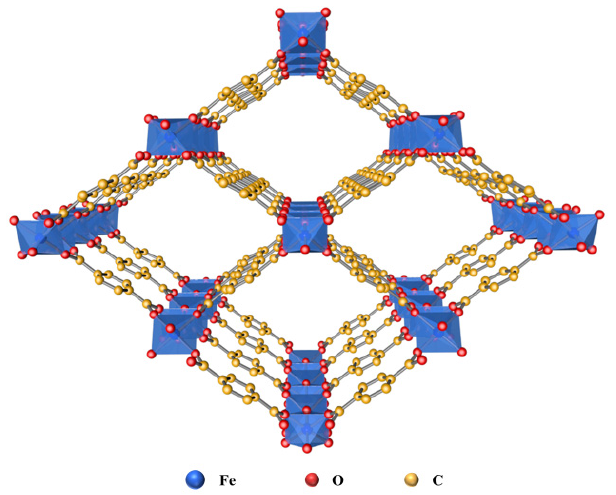
Figure 1. The schematic 3D representation of MIL-53.